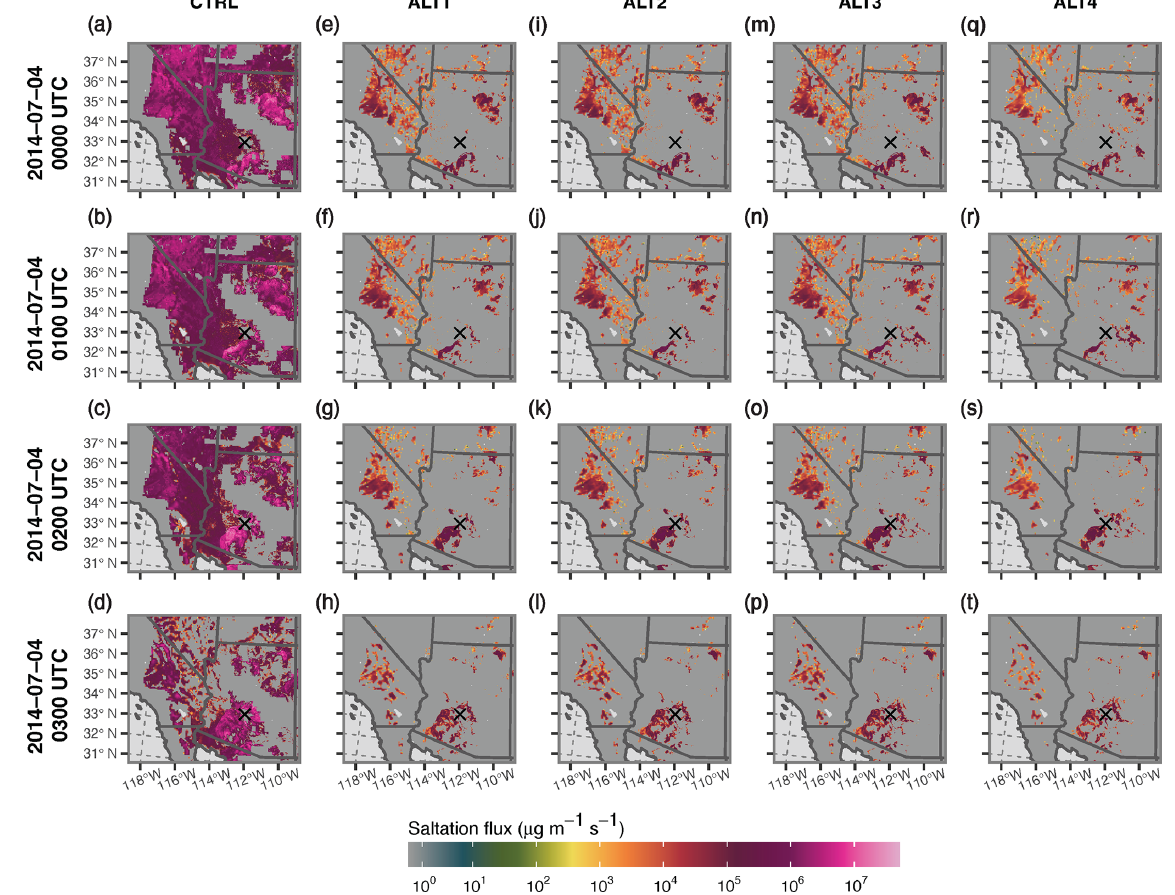
Figure 11. Times series of horizontal saltation flux ( Q ; µgm − 1 s − 1 ) for each test configuration (CTRL, ALT1, ALT2, ALT3, and ALT4) with non-erodible area masking applied from 00:00 to 03:00UTC on 4 July 2014. The black × marks the location of Phoenix,